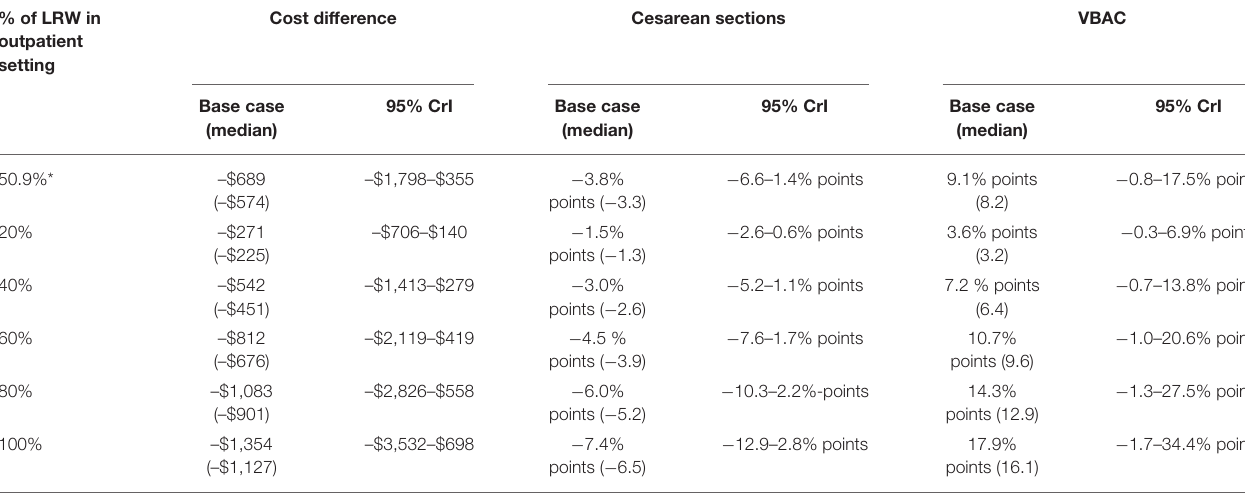
TABLE 4 | Multivariate probabilistic sensitivity analyses for increasing percentages of low-risk women ripened out of hospital with the synthetic hygroscopic cervical dilator. % of LRW in Cost difference Cesarean sections outpatient setting